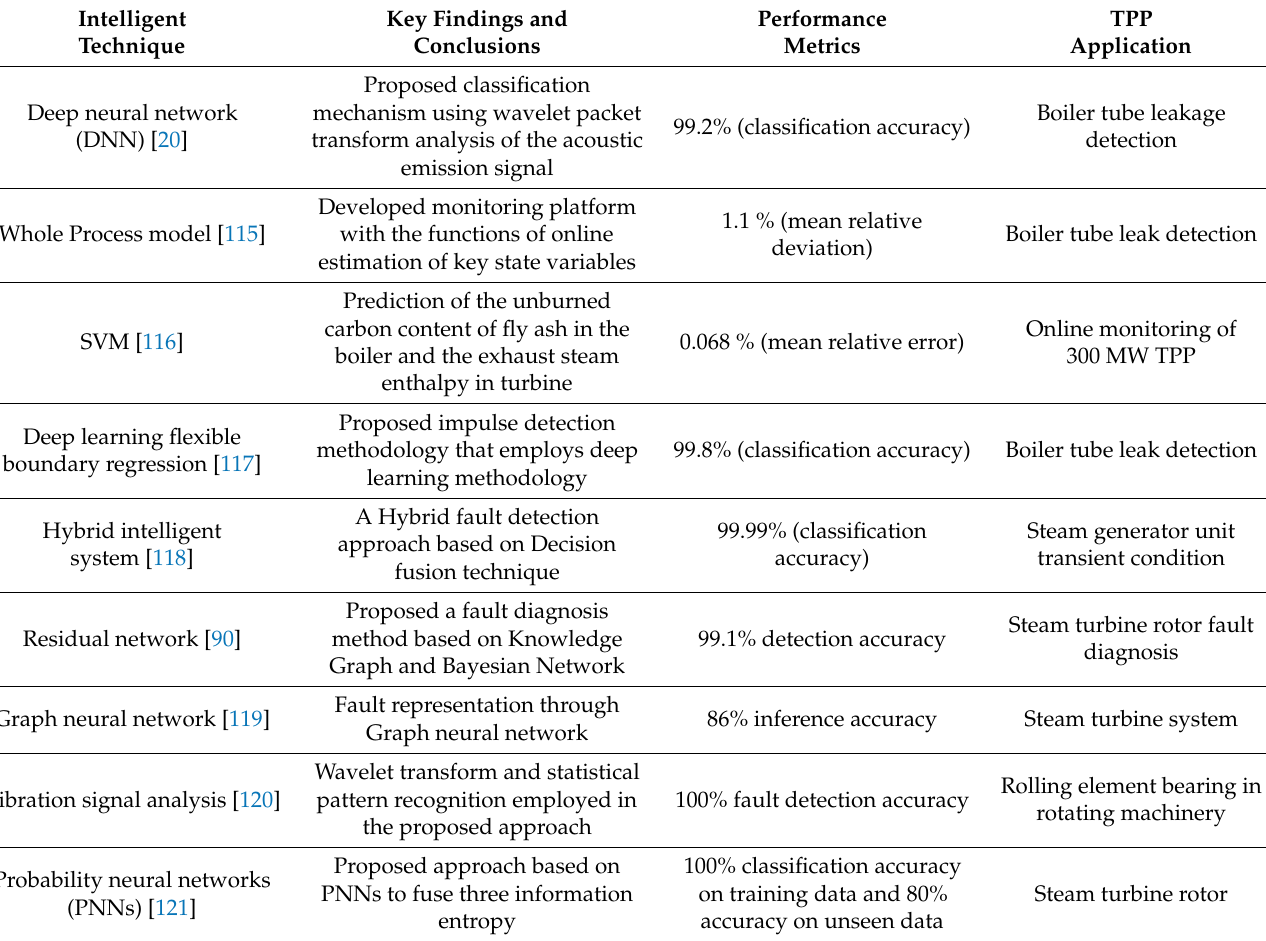
Table 7. Comparison of Intelligent Techniques for Thermal Power Plant